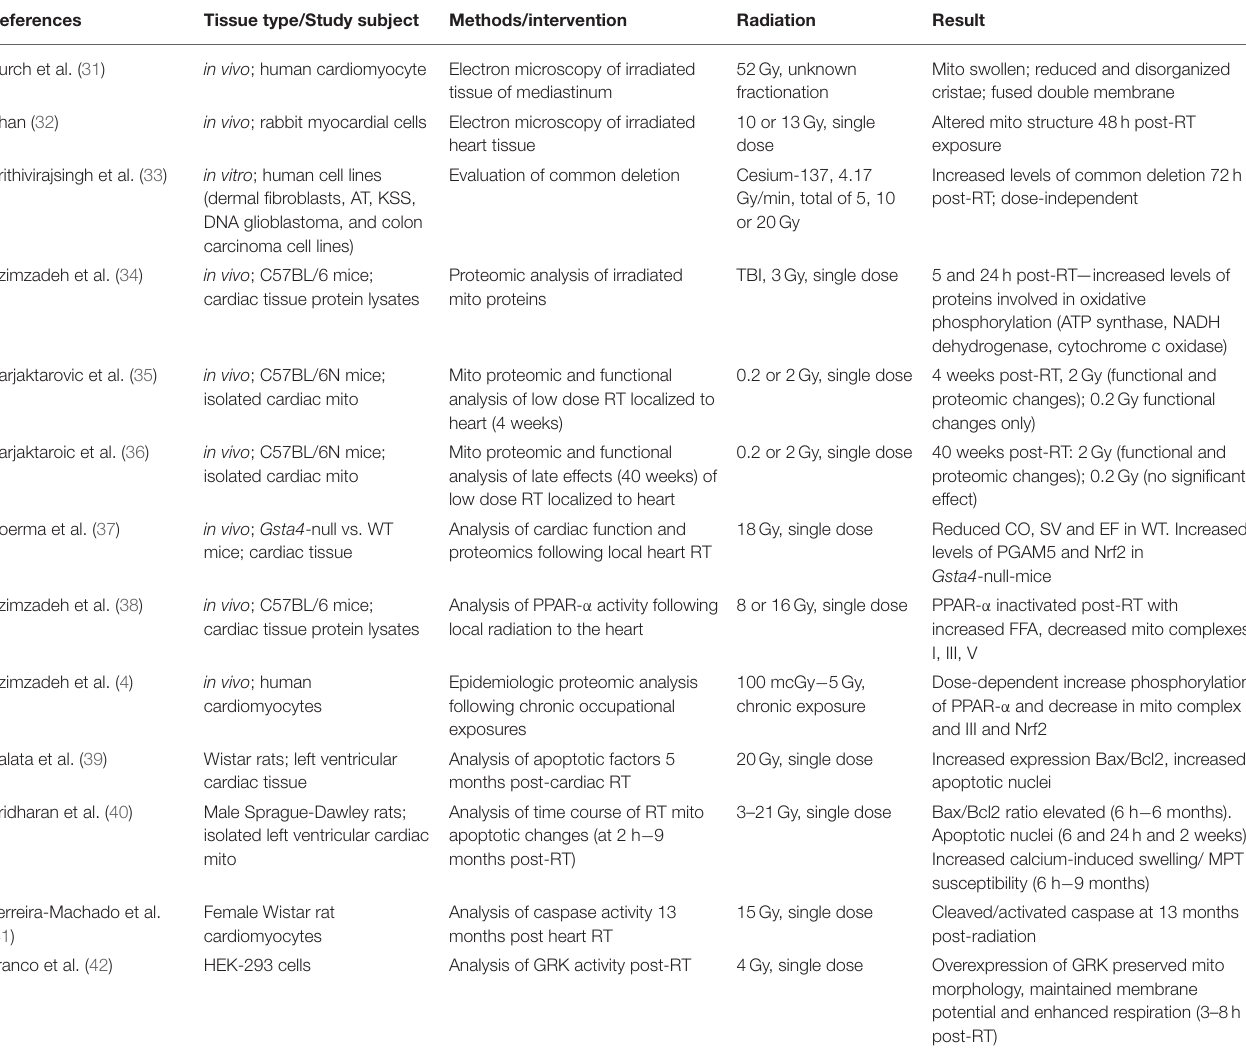
TABLE 1 | Summary of studies investigating the role of mitochondria in